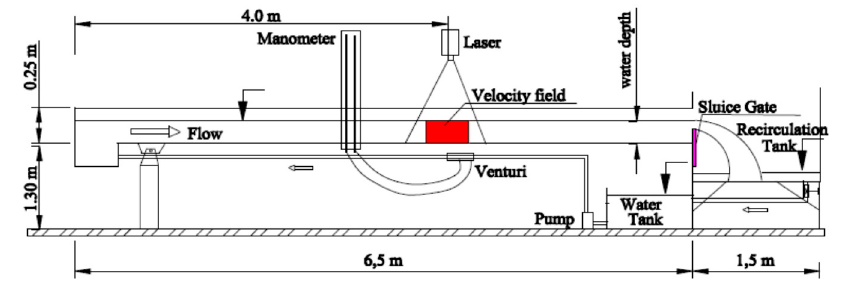
Figure 1. Experimental